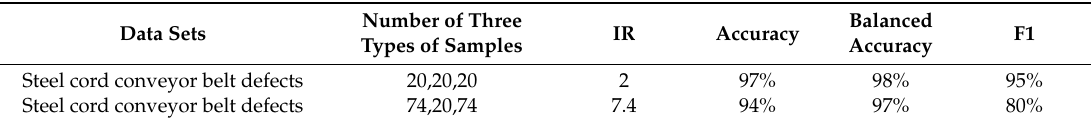
Table 6. The classification contrast results of the steel cord conveyor belt defects with different imbalanced ratio using the ISDTSVM